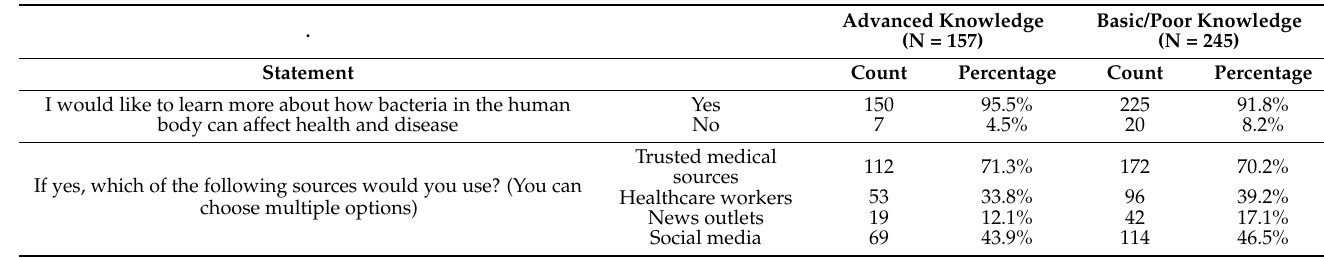
Table 6. Willingness to learn about